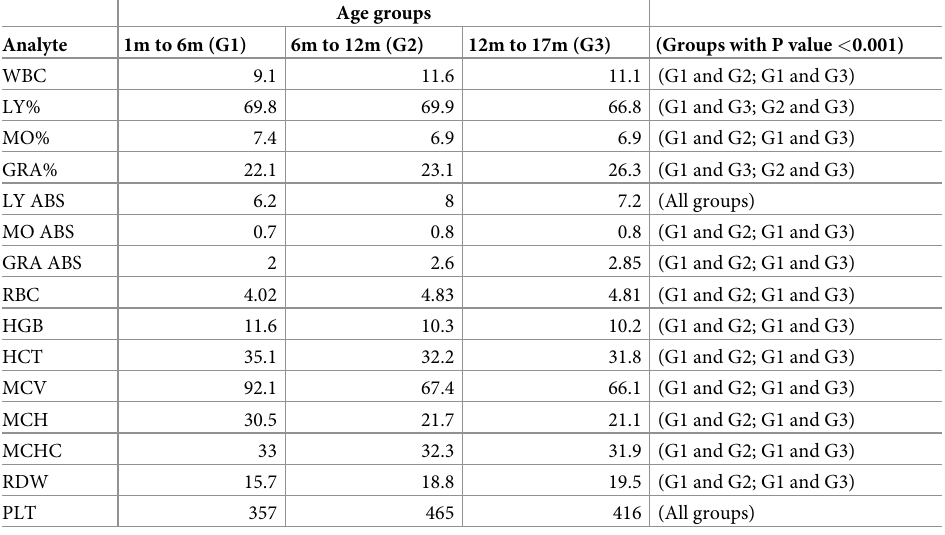
Summary of results showing median values of hematological and erythrocyte indices across different age